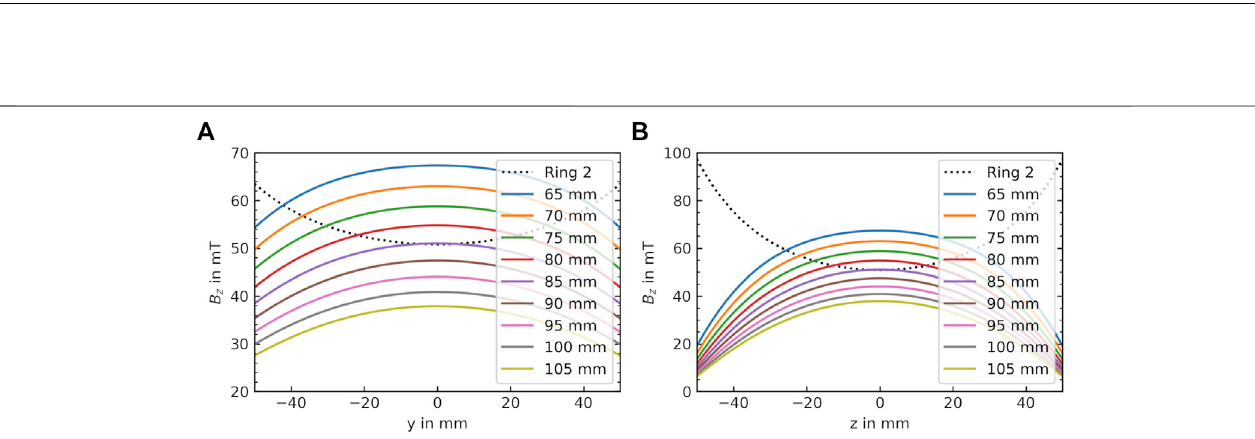
Frontiers in Physics |